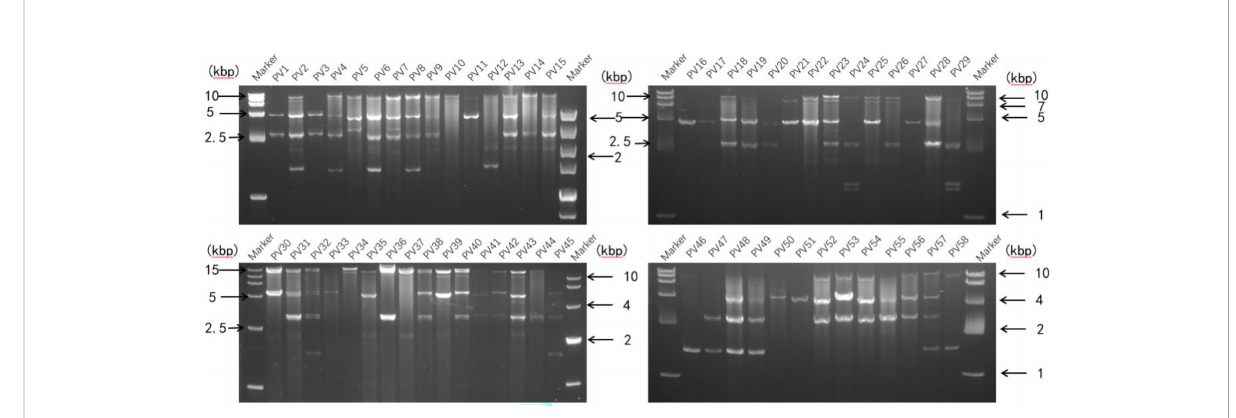
FIGURE 5 Agarose gel electrophoresis analysis of dsRNA extracted from P. vexans. Chromatography of cellulose extracts from the P. vexans strain showing dsRNA bands indicative of mycovirus infection.